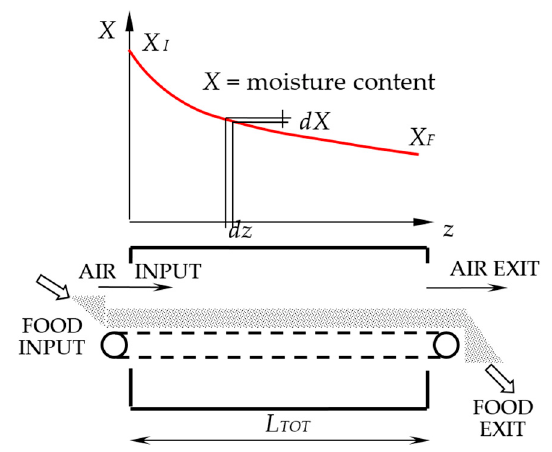
Figure 4. Conveyor-belt dryer with tangential flow completed with the moisture content product